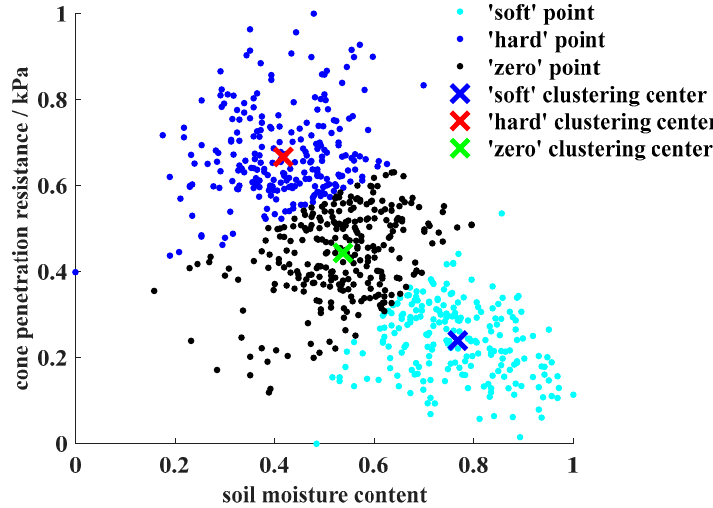
Figure 7. Clustering results of the soil’s physical state.